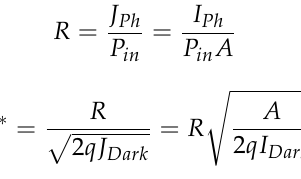
Blend 280k 2:1 TFT having a significantly higher recovery photosensitivity of